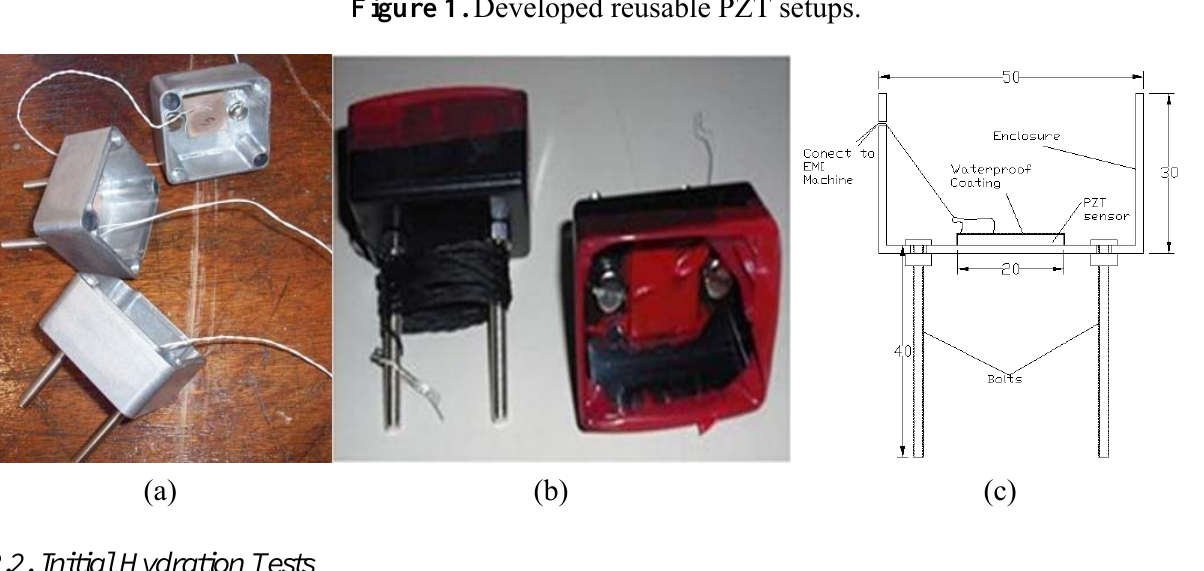
Figure 1. Developed reusable PZT